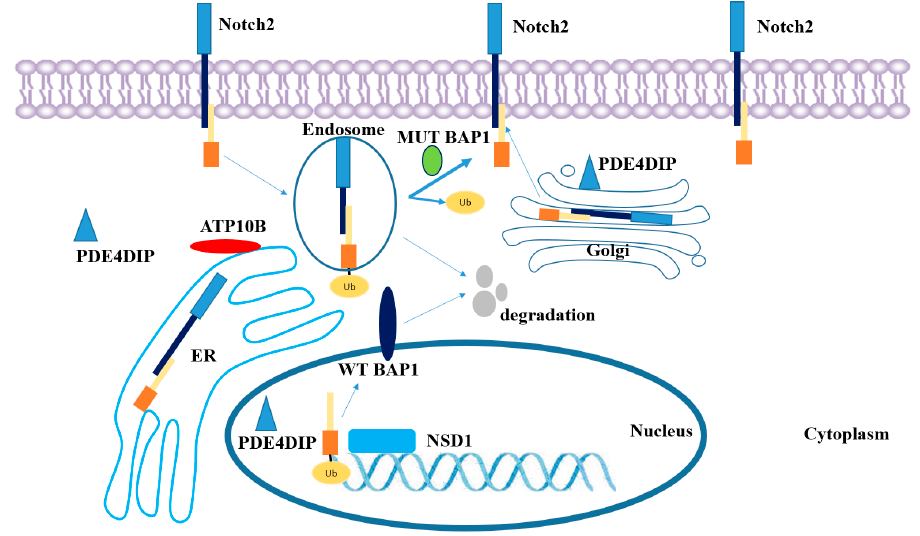
Figure 4. Notch signaling pathway and the localization of NSD1, BAP1, PDE4DIP and ATP10B in mesothelial cells.